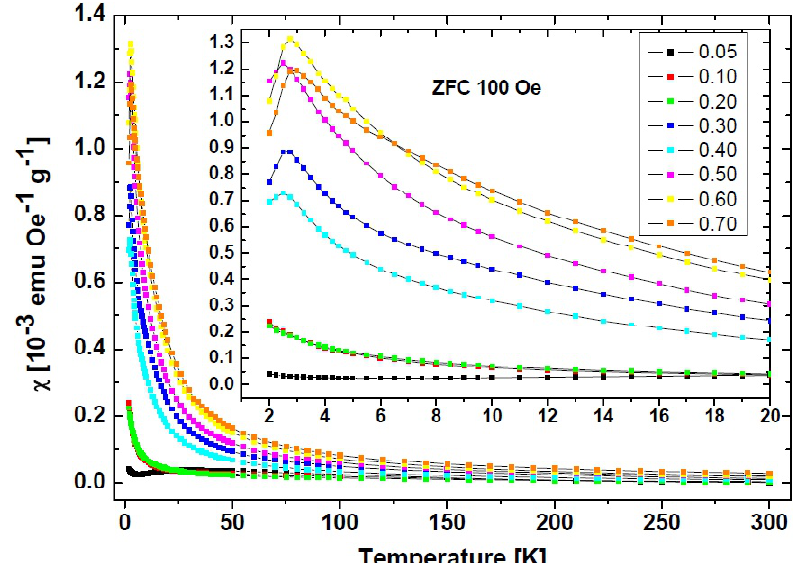
Fig. 1 . Temperature dependence of the dc magnetic susceptibility  ( T ) for all investigated samples in an external magnetic field H = 100 Oe measured in ZFC mode. The insert shows magnified view of  ( T ) curves in the low temperature range.